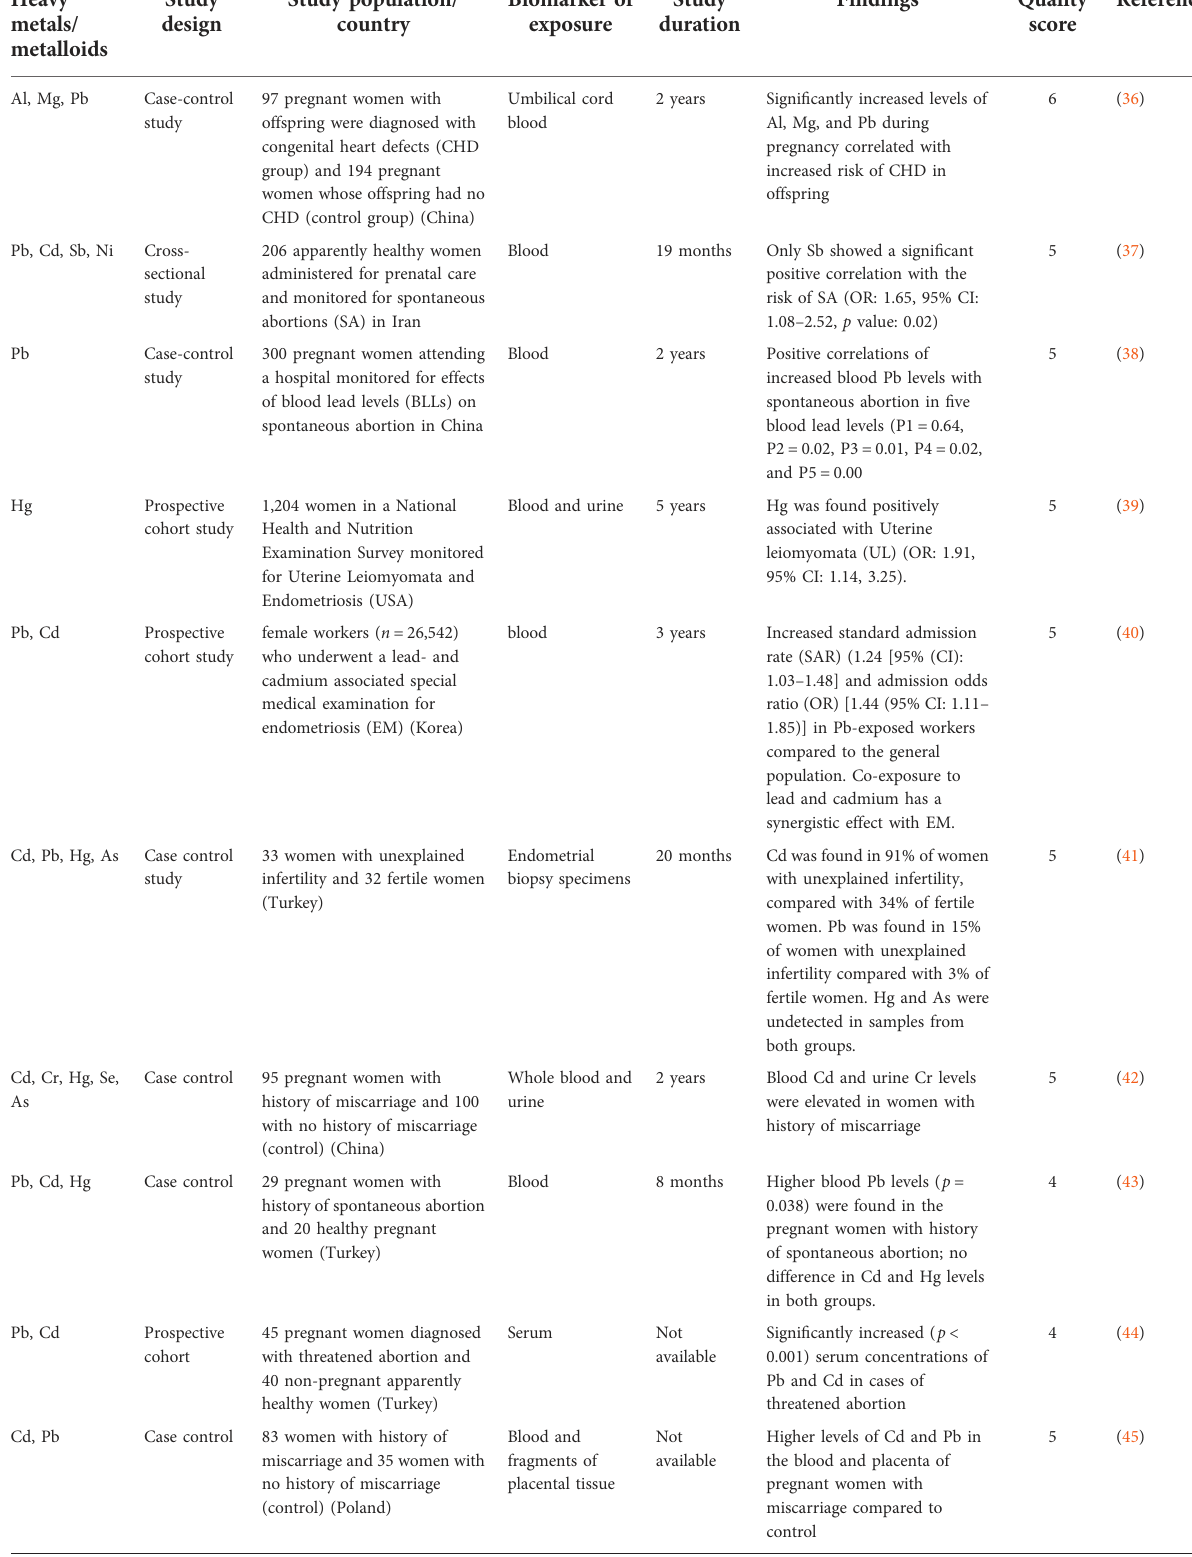
TABLE 2 Clinical studies on heavy metals/metalloids and reproductive